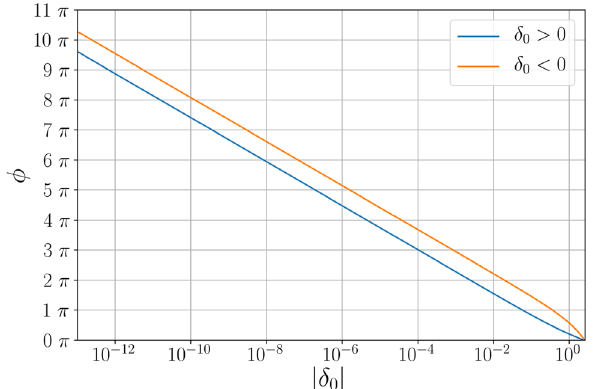
Figure 2. Angle of rotation for simulated light-rays as a function of deviations from the equilibrium (in 0 representing unbent light-rays. For both small positive and l / R s ) with φ dimensionless units with δ 0 = = negative perturbations a clear exponential relation to φ is